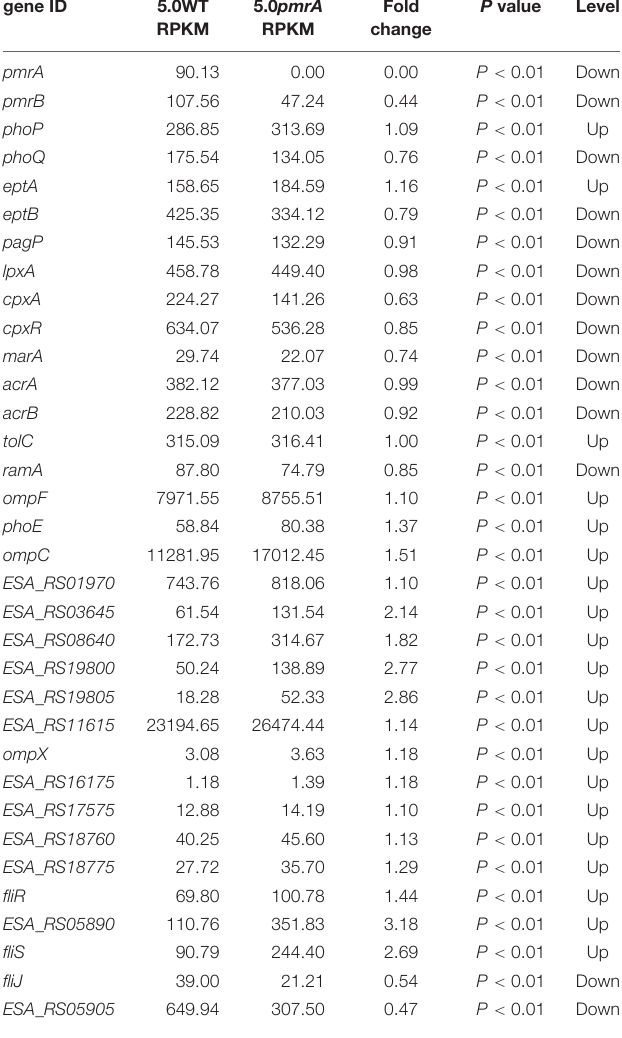
TABLE 3 | List of the genes related to phenotype between BAA894 and pmrA mutant in pH